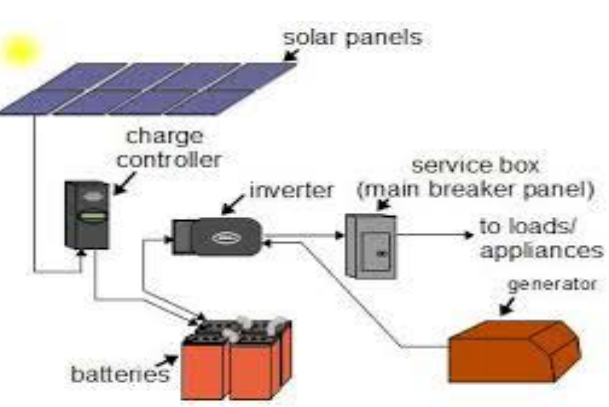
Figure 4: PV solar panel system to produce electricity (Rimstar,